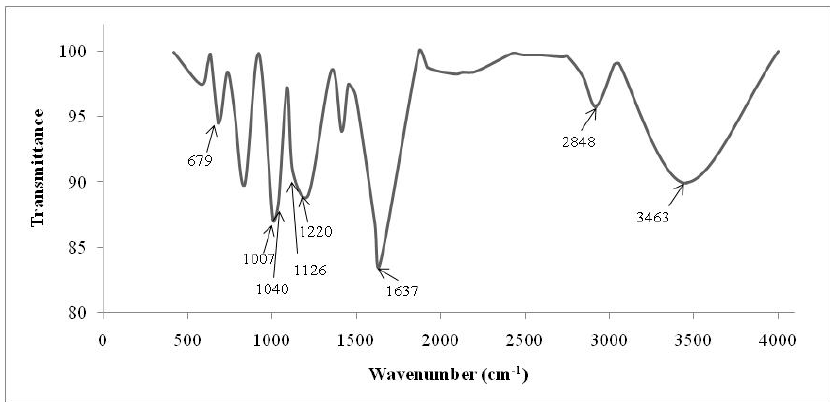
Table 3. Degradation of IER and Total Organic Carbon (TOC) in percentages.